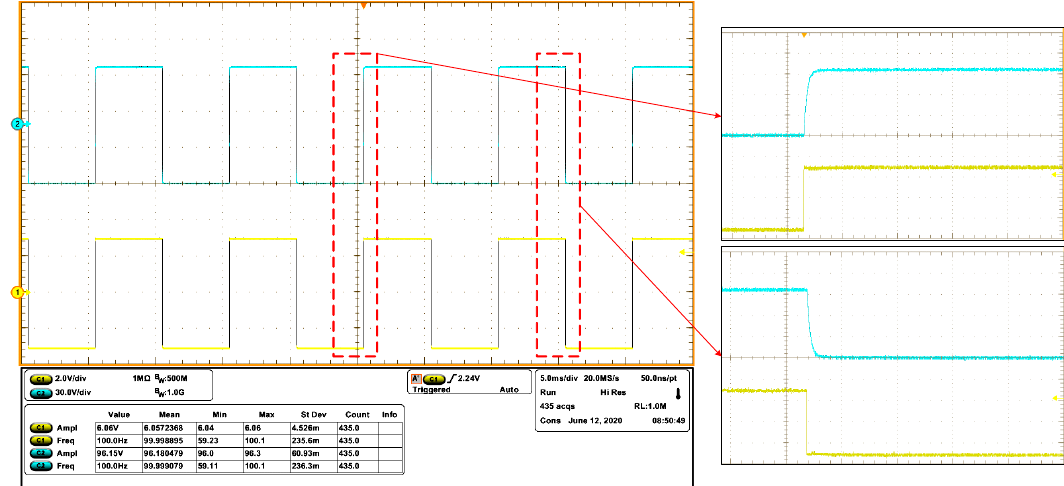
Figure 22. Measured waveforms of input (c1) and output (c2), as the input square wave has amplitude of 6 V and frequency of 100 Hz.